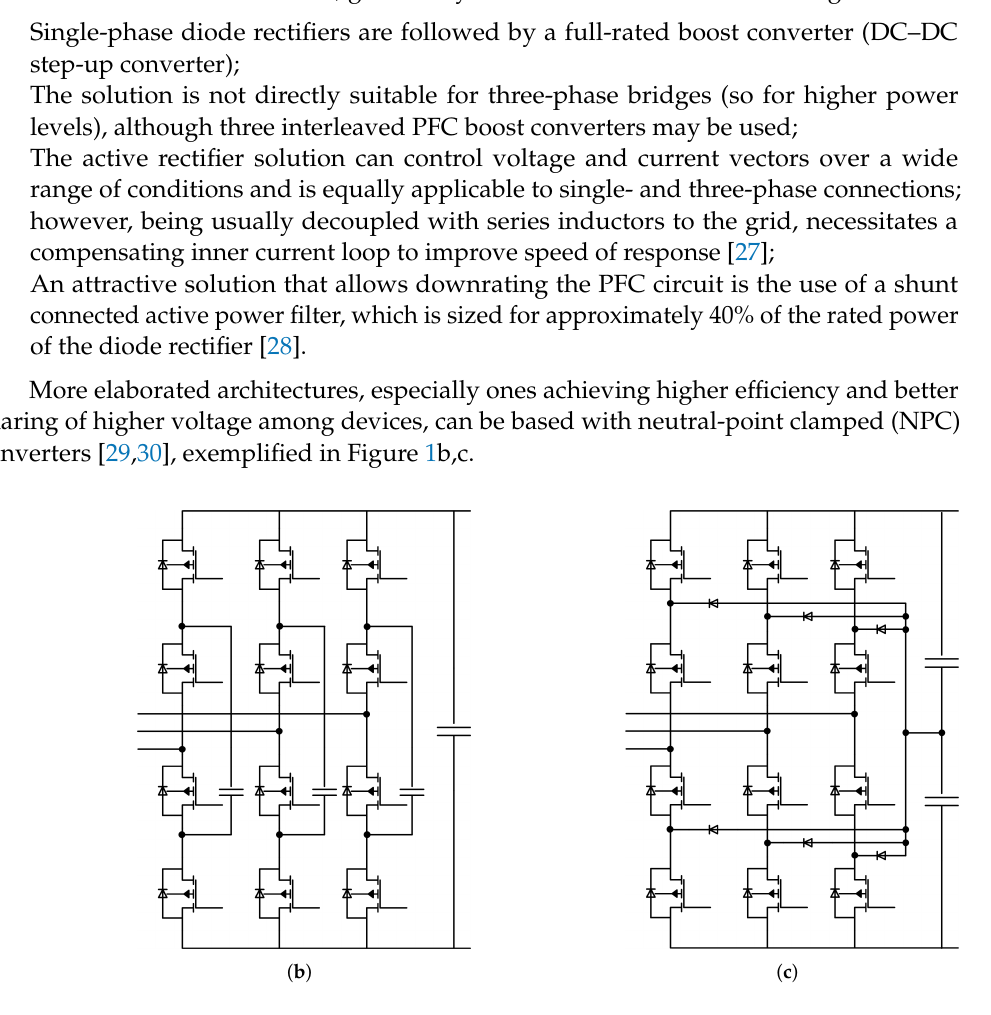
Figure 1. Typical AC–DC converter schemes (three-phase versions shown): ( a ) two-level active rectifier, ( b ) floating capacitor converter, ( c ) neutral point clamped